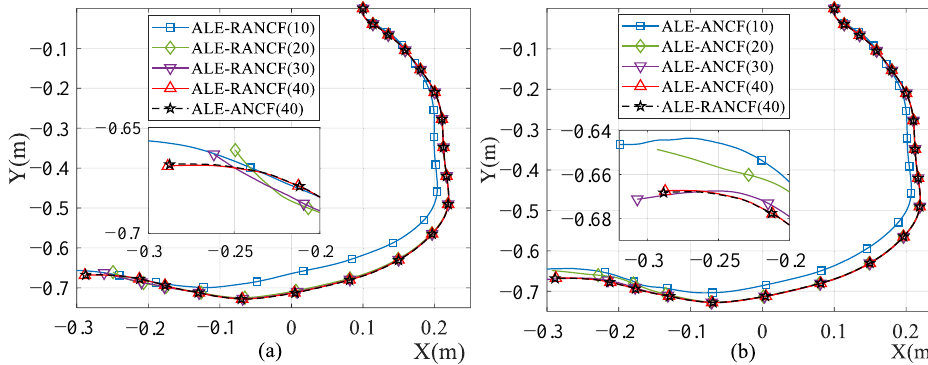
Figure 11. Trajectories of sliding nodes in ( a ) ALE-RANCF and ( b ) ALE-ANCF model.